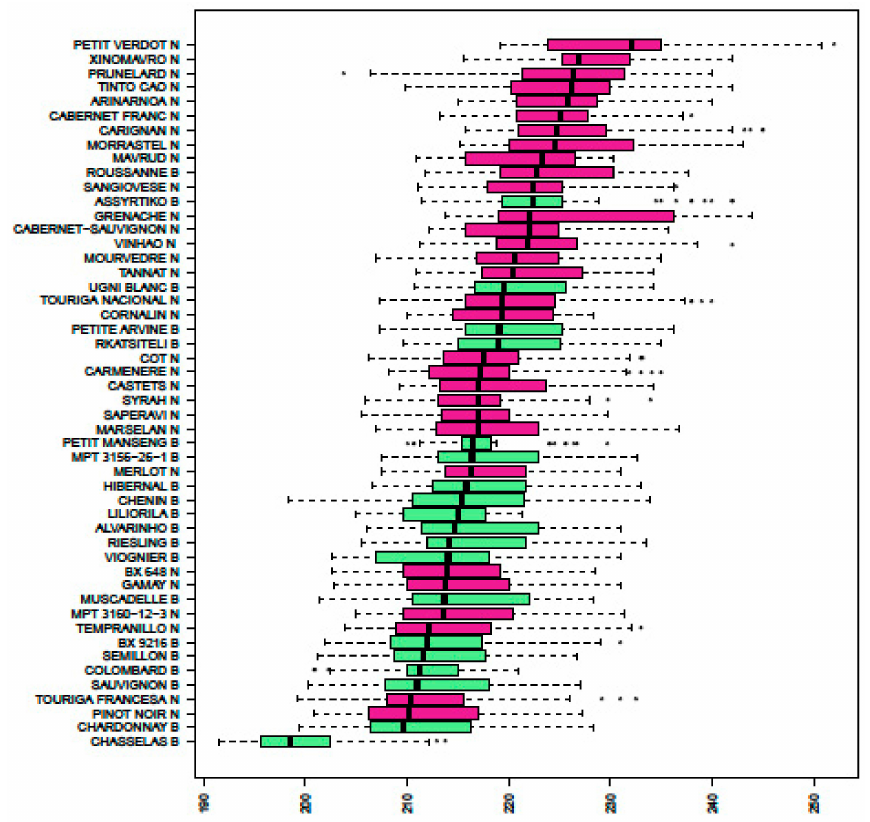
Figure 7. Boxplot of observed mid-v é raison dates of varieties planted in the VitAdapt experiment (average day of the year from four replicates per variety over the period